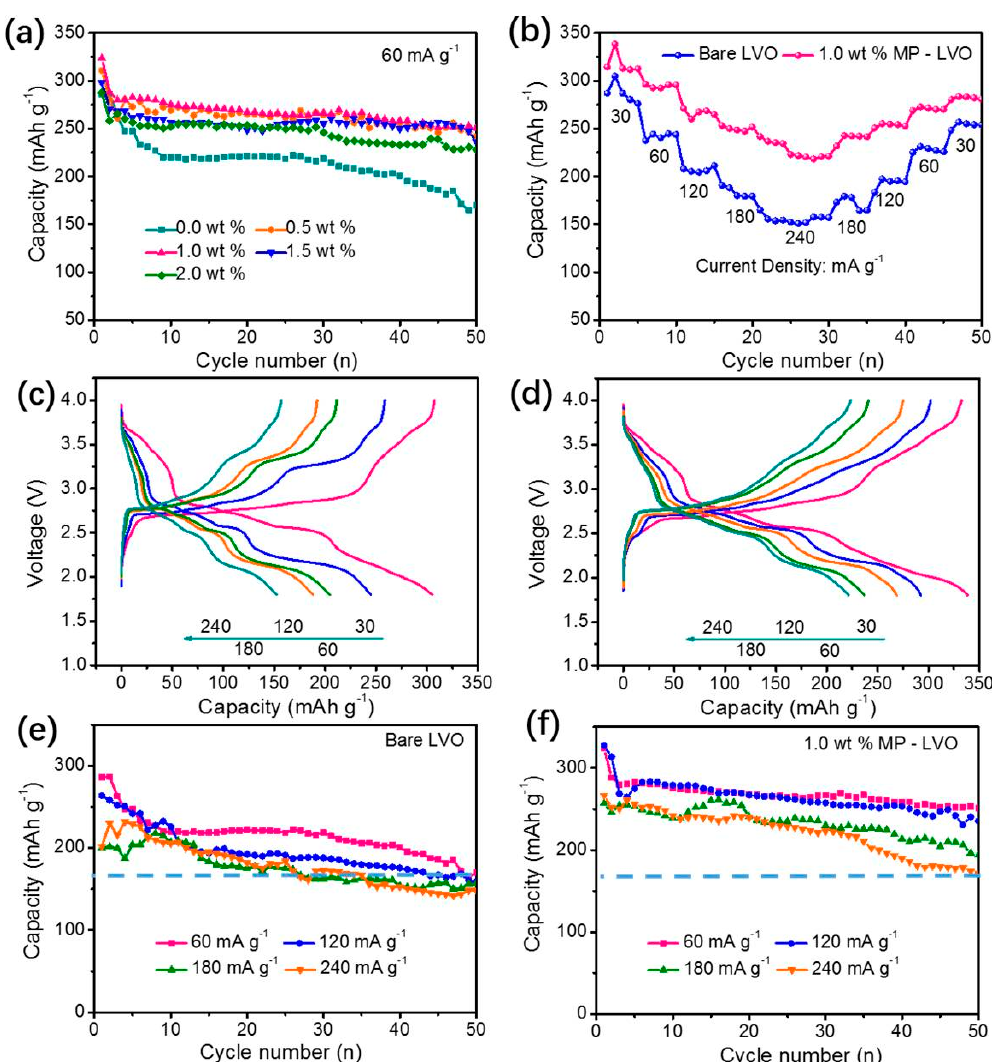
Figure 9. Cycling performance of MP-coated LVO samples with different MP contents at the current rate of 60 mA g 1 with the voltage range of 1.8 − 4.0 V ( a ), and stepped rate capabilities of the bare LVO and 1.0 wt.% MP-coated LVO samples ( b ). The corresponding charge/discharge profiles of the bare LVO ( c ) and 1.0 wt% MP-coated LVO ( d ) samples originating from Figure 5b. The long-term rate properties of the bare LVO ( e ) and 1.0 wt% MP-coated LVO ( f ) samples. Reprint with permission